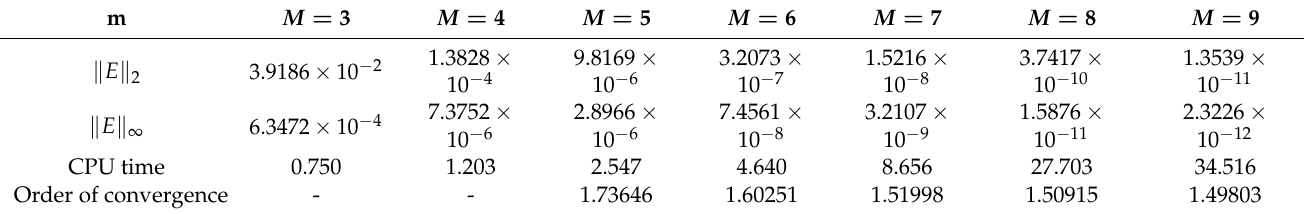
Table 6. The L ∞ , L 2 errors, CPU time and order of convergence for Example 4.